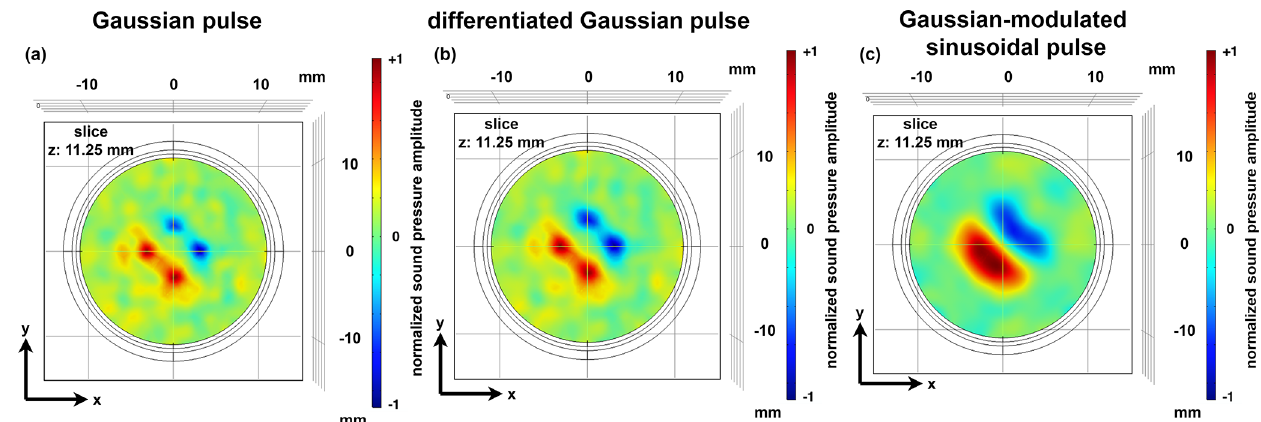
Figure 3. Representation of the sound pressure field in the x – y plane of the cavity depending on the calibration signal used. (a) Gaussian pulse, (b) differentiated Gaussian pulse and (c) Gaussian-modulated sinusoidal burst.